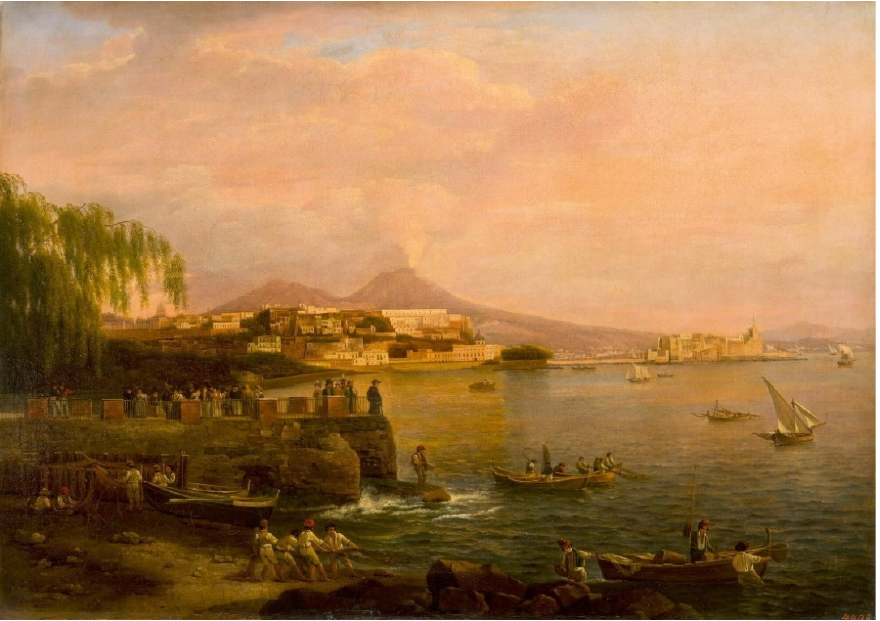
Figure 23. Sylvester Shchedrin. A View of Naples from the Garden of the Royal Palace , 1820. State Russian Museum, Saint Petersburg.